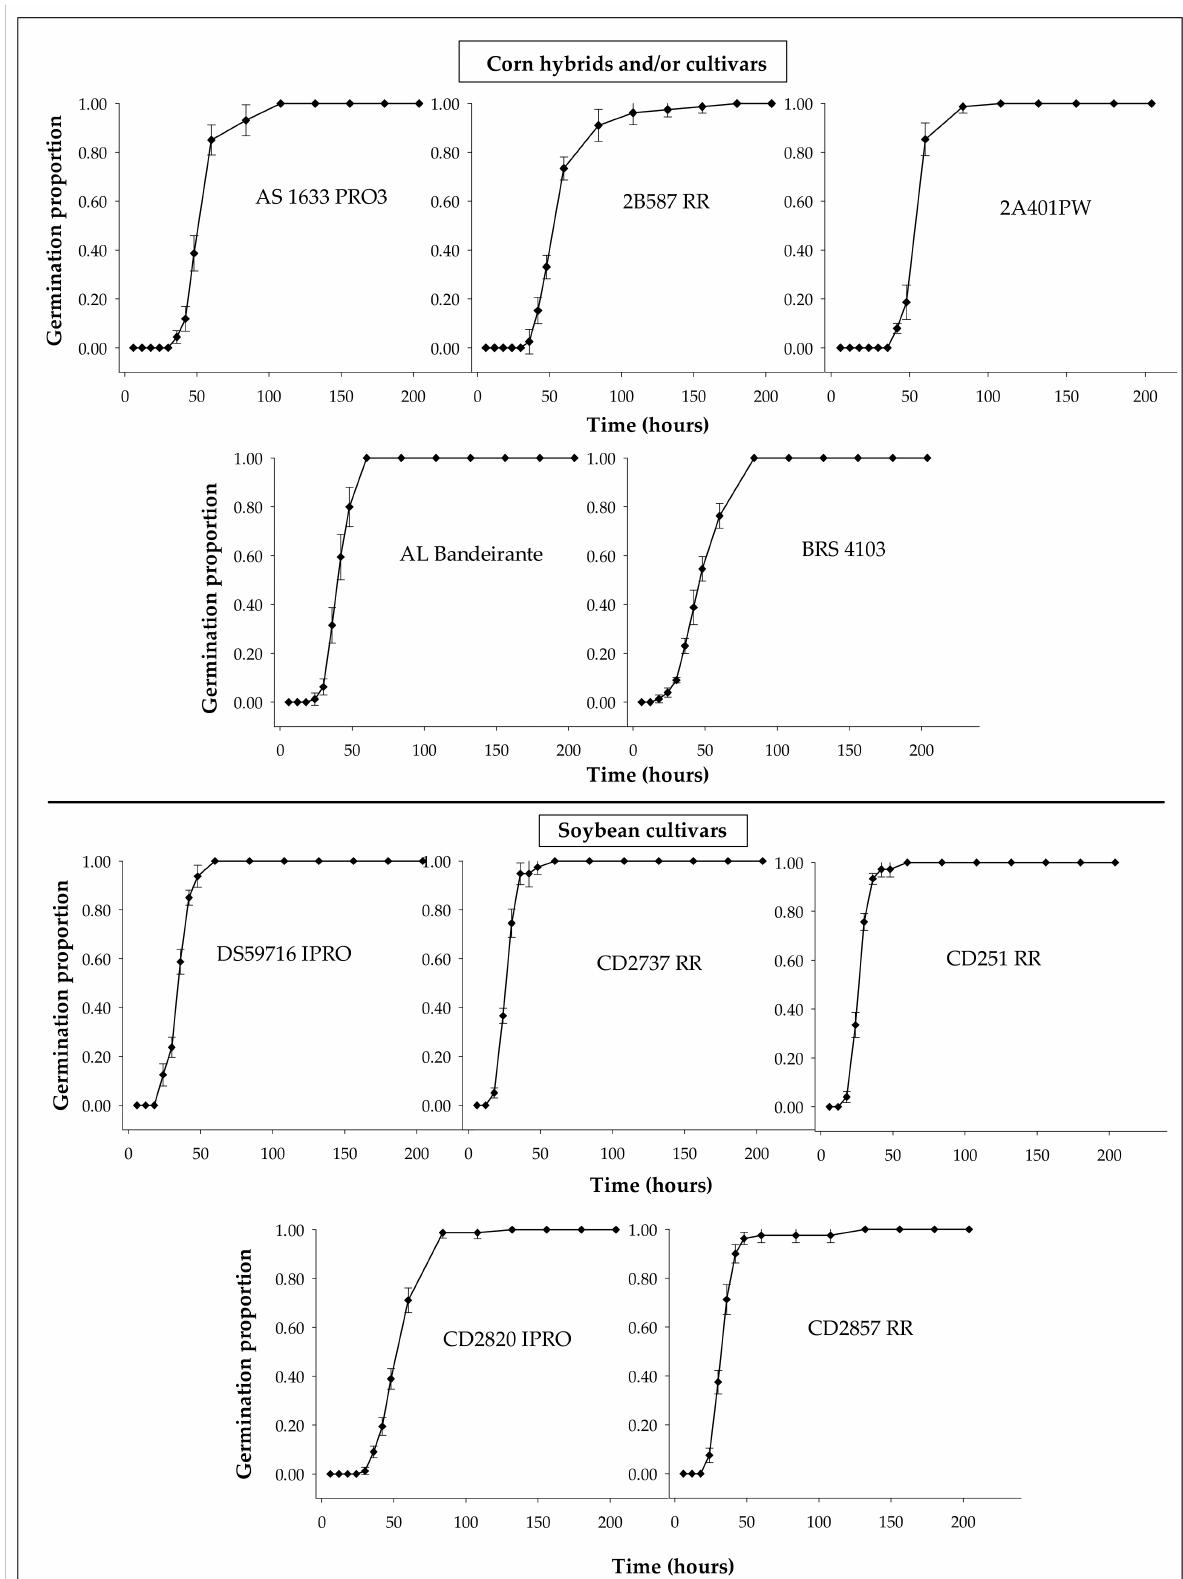
Figure 1. Germination process of corn and soybean hybrids and/or cultivars (mean ± standard deviation of germination proportions at 15 independent points in